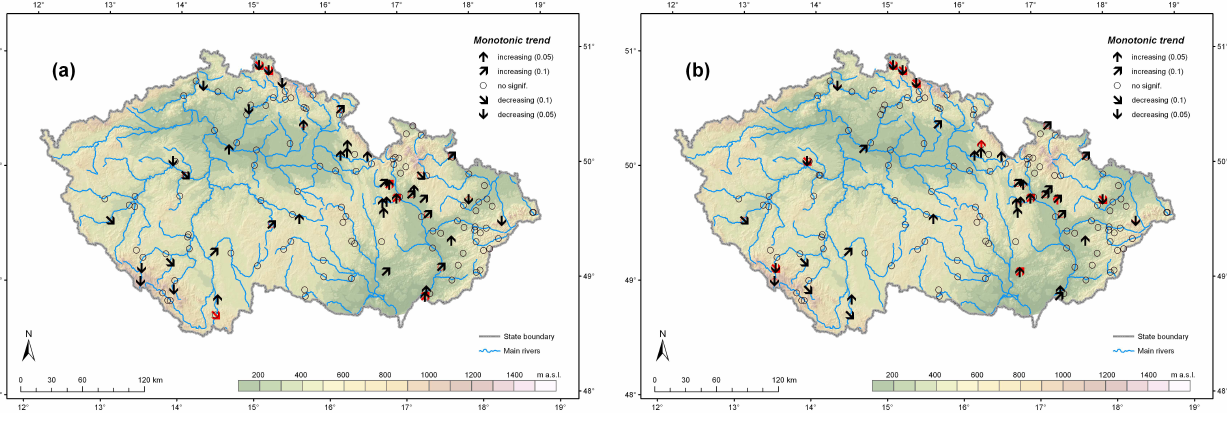
Figure 3. Spatial distribution of trends in annual deficit volumes V 355 (a) and trends in annual numbers of days with discharge under the quantile Q 355d (b) in Czechia during the period 1961–2005 (black symbols – ABBS–MK test, red symbols – BHMLLESS–MK